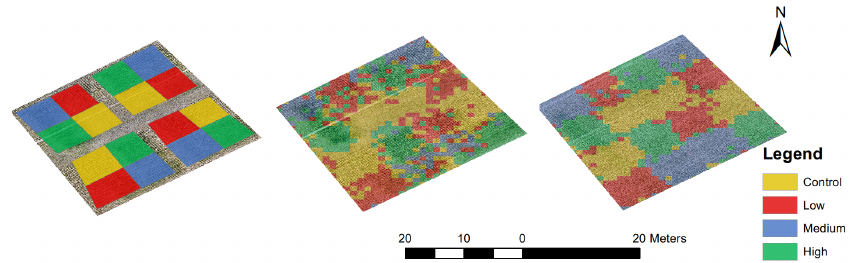
Figure 9. The nitrogen status estimation result on drone images captured at the tillering and stem extension